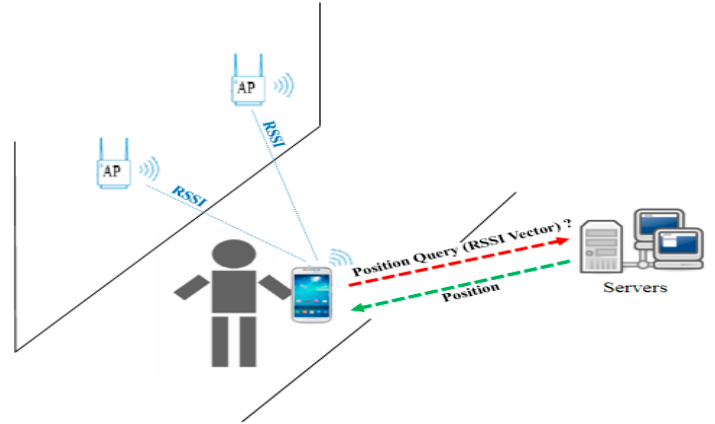
Figure 8. Illustration of the proposed fingerprint-based Wi-Fi positioning system.